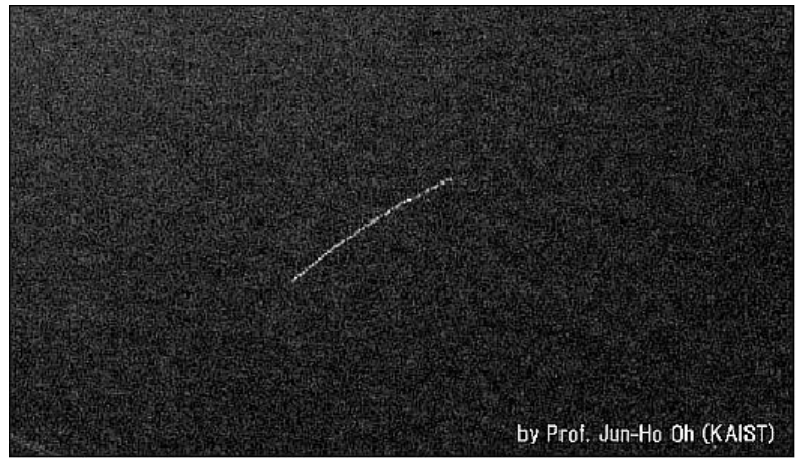
Figure 2. The first LED flashing of FITSat-1 as reported by Kazuhisa Mishima of the Kurashiki Science Center (Japan) and by Jun-Ho Oh of KAIST (Korea Advanced Institute of Science and Technology) (image credit: